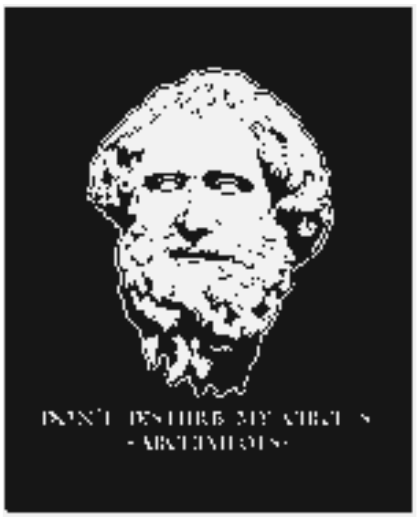
Figure 31. Archimedes using FCM. Figure 32. Archimedes using Figure 32. Archimedes using FP-Conv-CM . Figure 33. Khwarizmi using GMM. Figure 34. Khwarizmi using FCM. Figure 35. Khwarizmi using FP-Conv-CM.